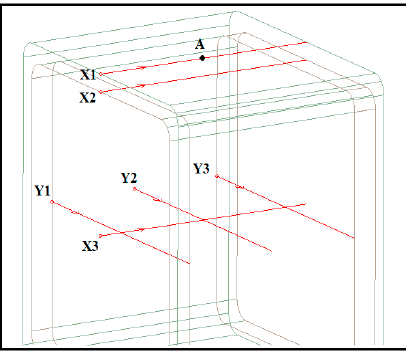
Figure 9. Measurement lines across the simulation model.